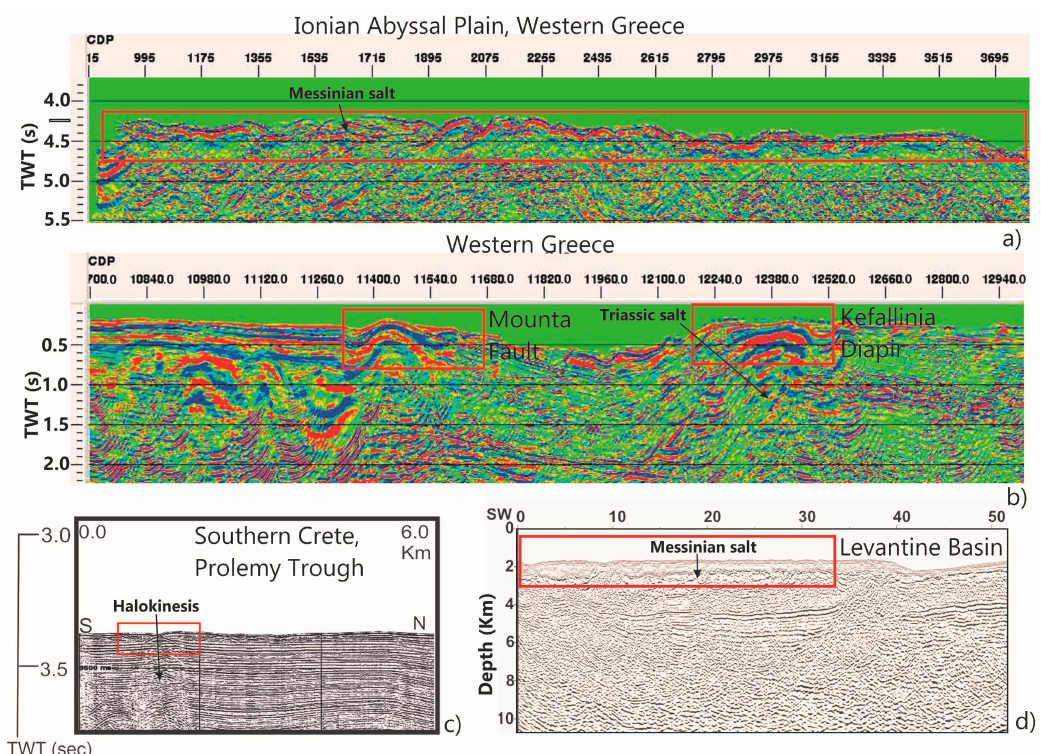
Figure 7. Seismic reflection profiles highlighting the styles of seafloor deformation due to the presence of underlying salt—see red rectangles. TWT corresponds to two way travel time. The locations of the seismic reflection sections are shown in Figure 1. These high-resolution 2D profiles image Messinian salt (a) in the Ionian Abyssal Plain, together with underlying Triassic evaporites; ( b ) around the Kefallinia Diapir [51]; ( c ) N–S trending high-resolution 2D profile from the Ptolemy trough, Southern Crete (Greece), imaging very moderate deformation of the seafloor owing to halokinesis [43]; ( d ) NE–SW trending high-resolution 2D profile located SW of the Eratosthenes Seamount revealing the presence of Messinian salt in the Levantine Basin